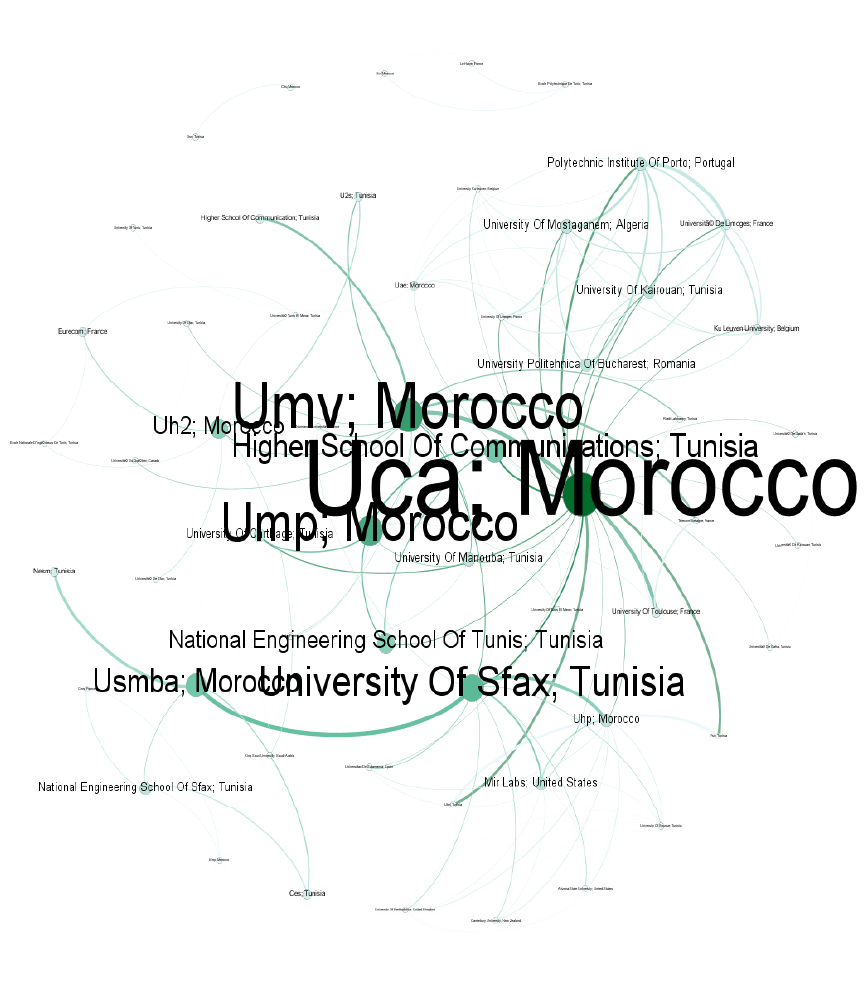
Fig. 4. Mapping of scientific collaboration between the affiliates of Morocco and Tunisia in "computer Science" from 2007 to